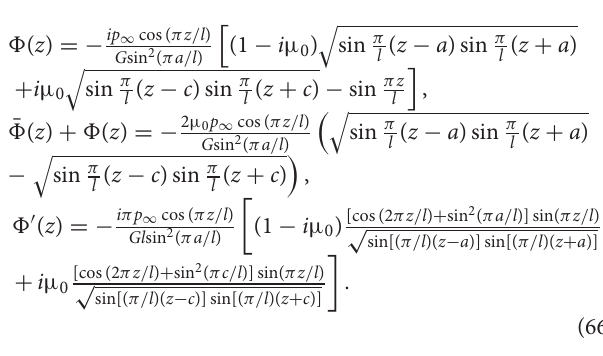
and taking into account (Equation 56), we obtain ip cos( π z / l ) 8 ( z ) ∞ G sin 2 ( π a / l ) = −